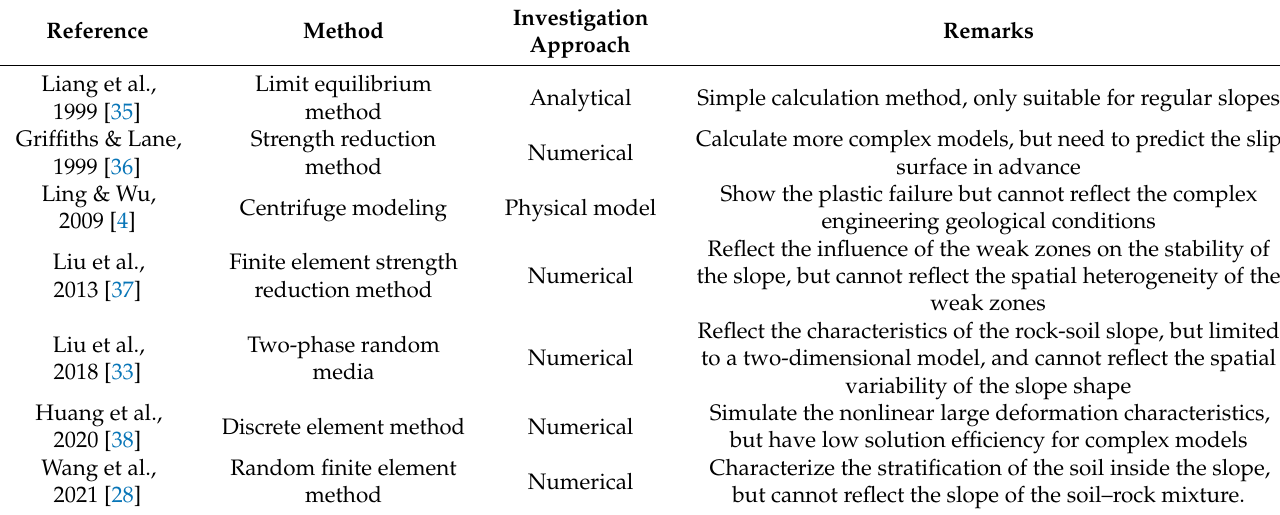
Table 1. Summary of typical investigations on the analysis of slope